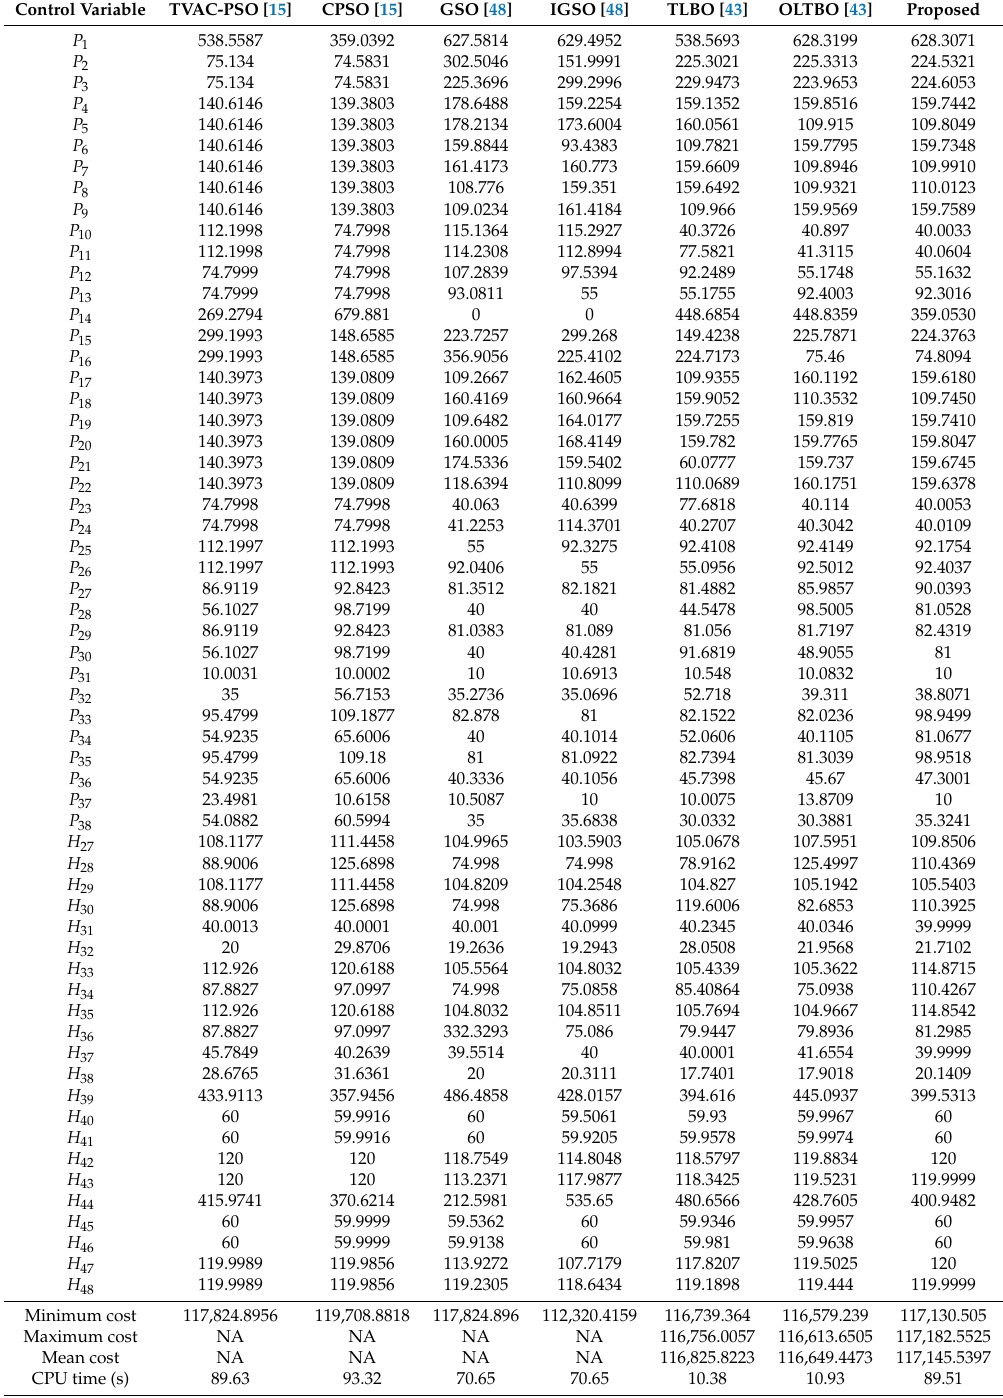
Table 12. Comparison of the obtained results for 48-unit test